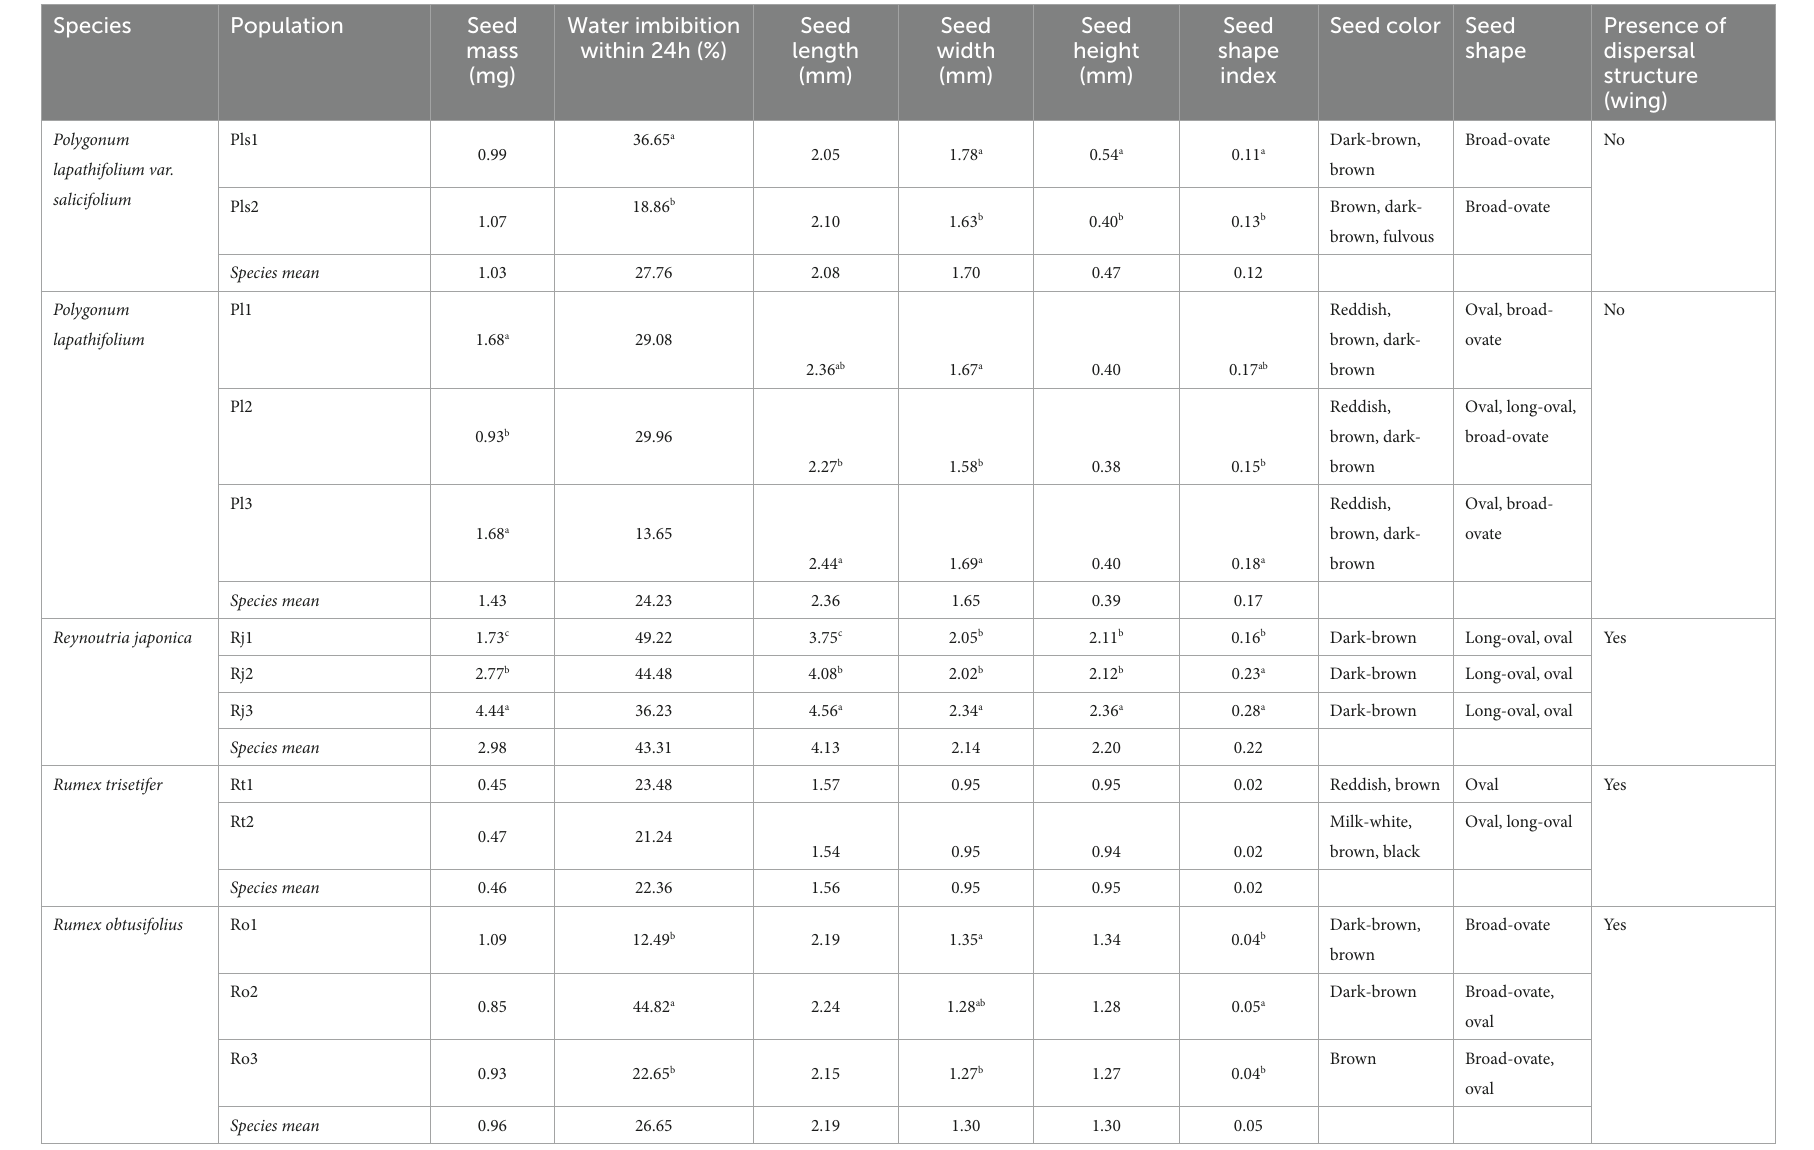
TABLE 2 Interpopulation variation in seed traits of five Polygonaceae species.